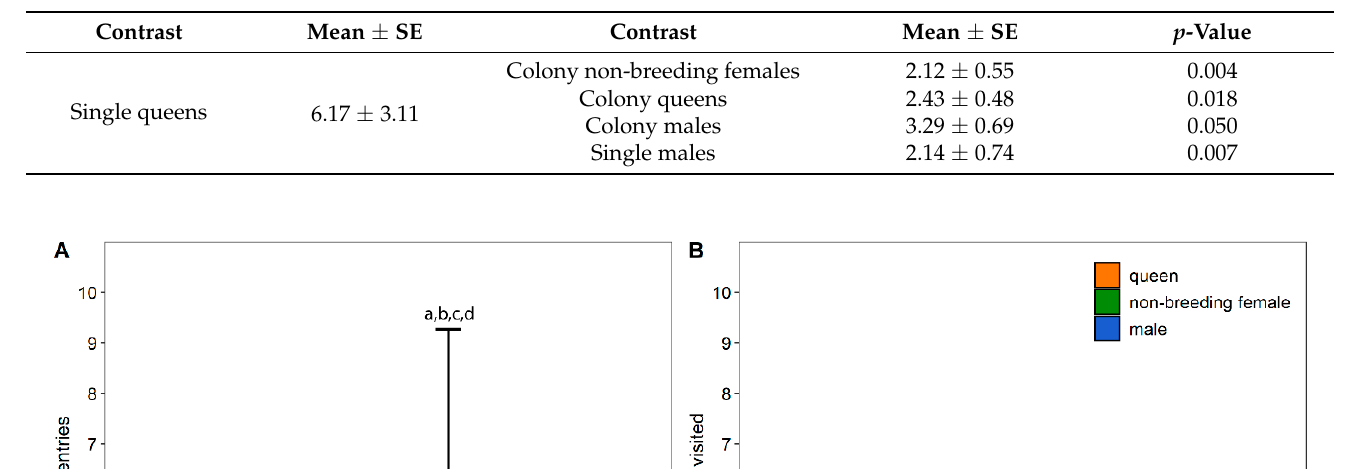
Table 1. Post hoc significant differences in the mean total number of tunnel entries between experi- mental groups in Experiment 1.